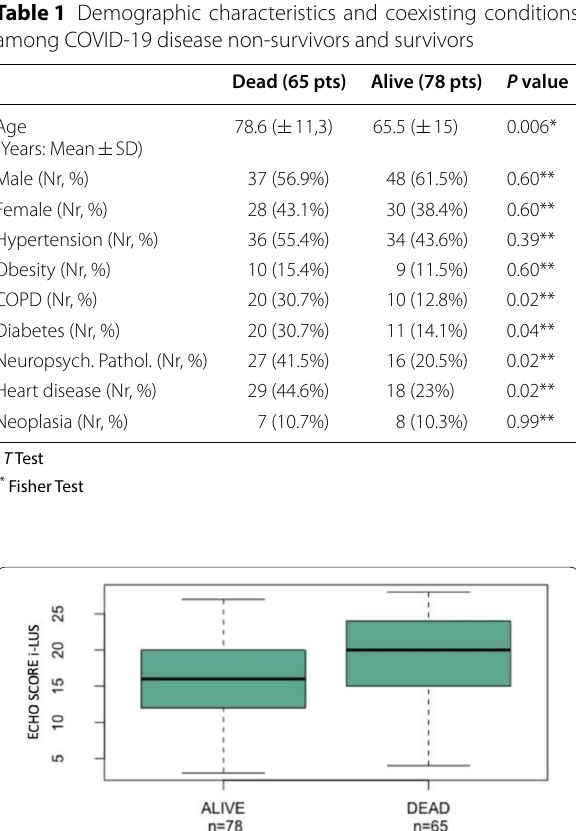
Fig. 3 Boxplots—Echo Score i-LUS (i-LUS) and survival ( p value 0.005136) =